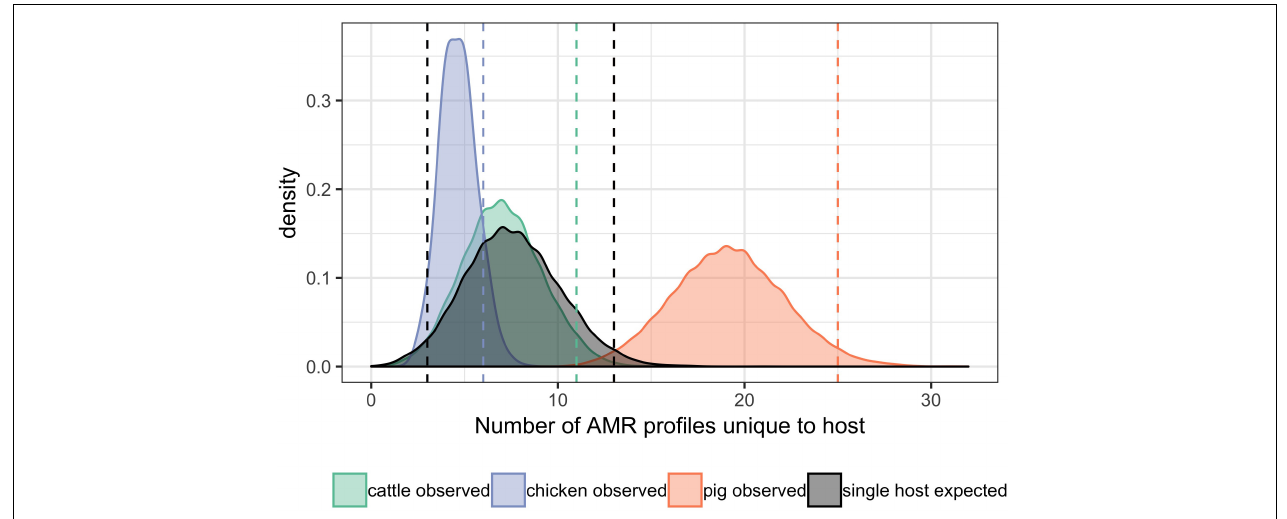
FIGURE 4 | Differences in the observed number of AMR profiles unique to individual hosts compared with number expected for a single host. Bandwidth = 0.5. Vertical dashed orange lines: first and last 2.5th percentiles of values of pig observed data. Vertical dashed green line: last 2.5th percentile of values of cattle observed data. Vertical dashed blue line: last 2.5th percentile of values of chicken observed data. Vertical dashed black lines: first and last 2.5th percentiles of expected values for a single host. The lower 2.5th percentile vertical line of observed values from cattle and chickens overlap with lower 2.5th percentile vertical line for expected values for a single